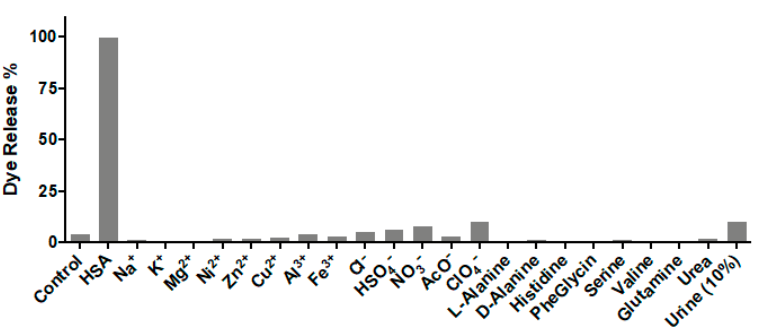
Figure 4. Fluorescence intensity at 571 nm of rhodamine B released from S1 suspensions in PBS (pH 7.4)-acetonitrile 95:5 v / v after 5 min of HSA (10 μM) and selected interfering molecules (10 μM) addition. Synthetic urine was dissolved in PBS (pH 7.4)-acetonitrile 95:5 v / v at 10% concentration.